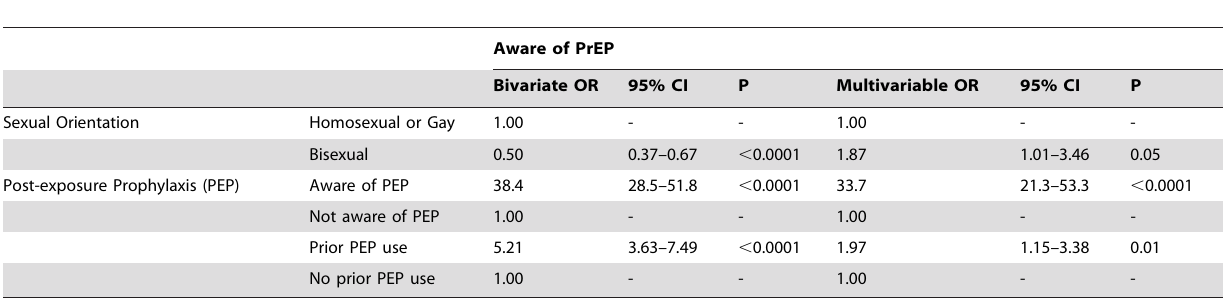
Table 2. Participant Characteristics associated with Awareness of Pre-Exposure Prophylaxis (n= 642) One Month after Publication of Efficacy Results (the iPrEx